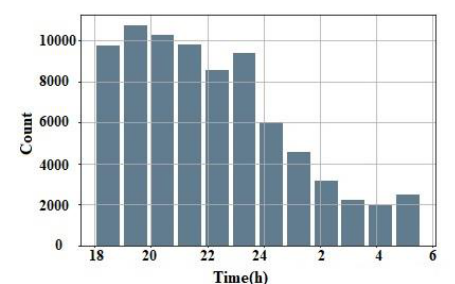
Figure 7. Number of emergency medical travels in different time periods at night.